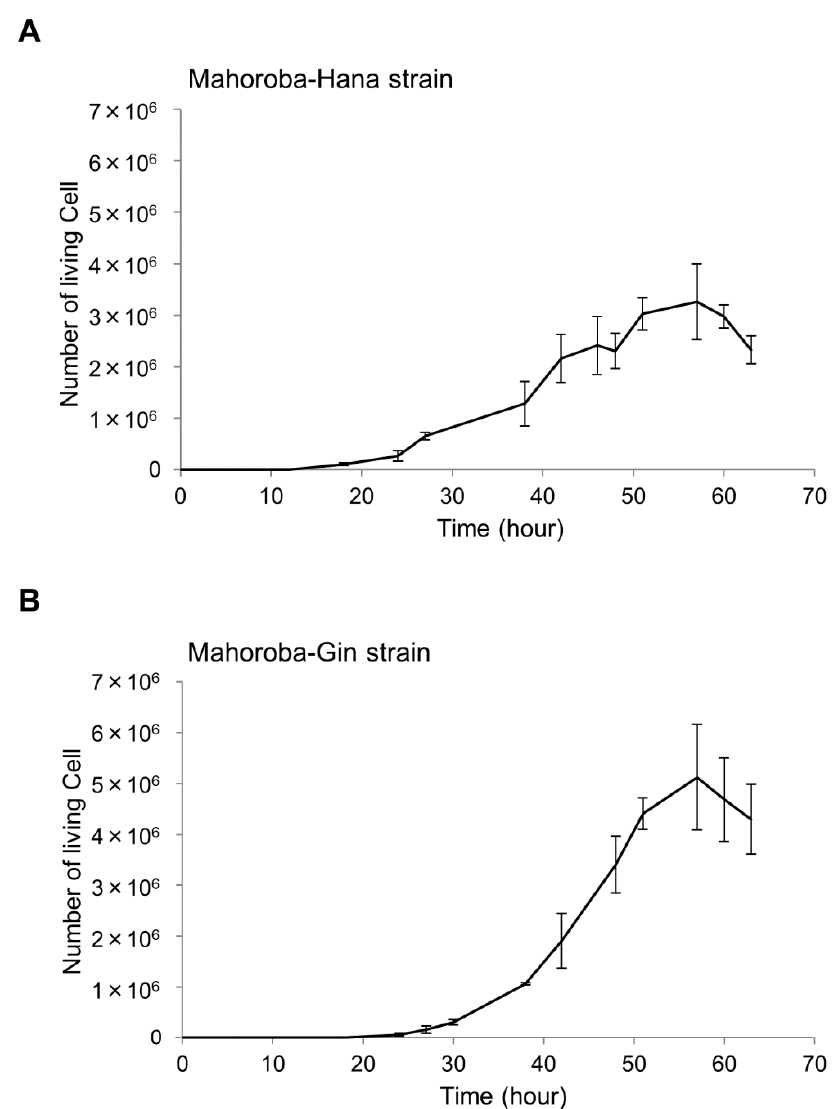
Figure 3. Growth curves of two yeast strains. The number of living cells was enumerated for the Mahoroba ‐ Hana ( A ) and Mahoroba ‐ Gin strains ( B ). Mahoroba-Hana ( A ) and Mahoroba-Gin strains ( B